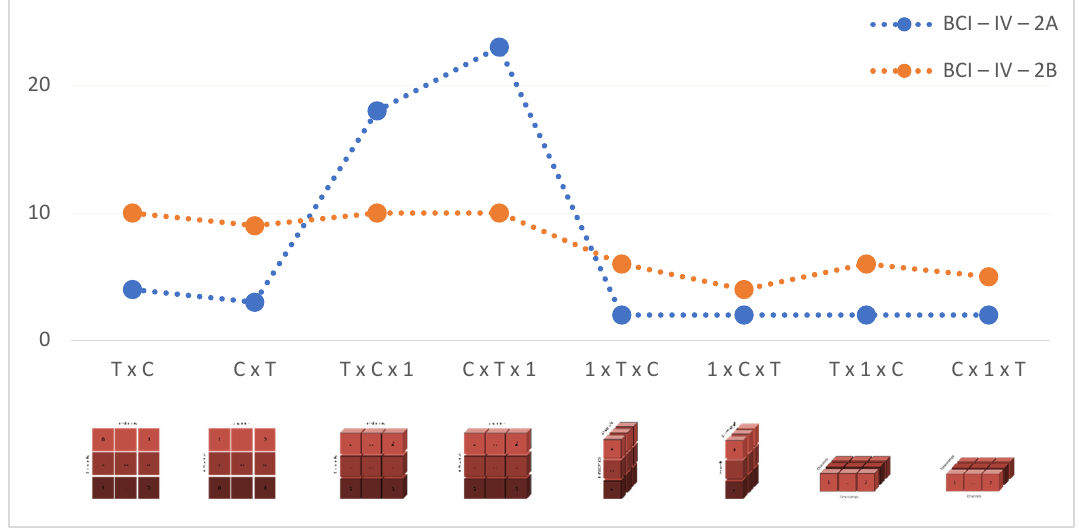
Figure 7. Epoch Times for each Input Shape.